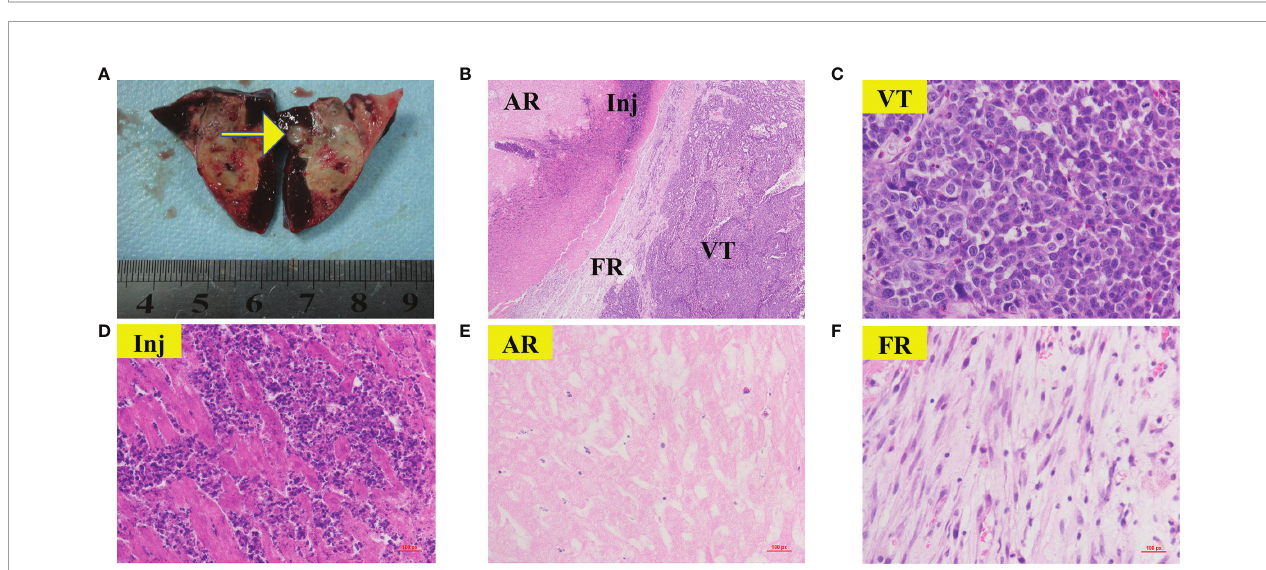
FIGURE 7 | Gross morphology and histological images of viable tumor. The areas represented from periphery to center are as follows: viable tumors (VT); reaction zone (RZ); ablation region (AR) Gross morphology image of viable tumor ( A , yellow arrow) was appeared as nodular located on the periphery of the RFA region. 40× H&E histology (B) showed VT can in fi ltrate and compress the fi brous rim, causing local RZ thinner than the adjacent tumor-free area. (C – F) showed 400× H&E histology of VT (C) , Inj (D) , AR (E) and FR (F) from (B) . (C) showed typical clumps of heteromorphic tumor cells with large, hyperchromatic